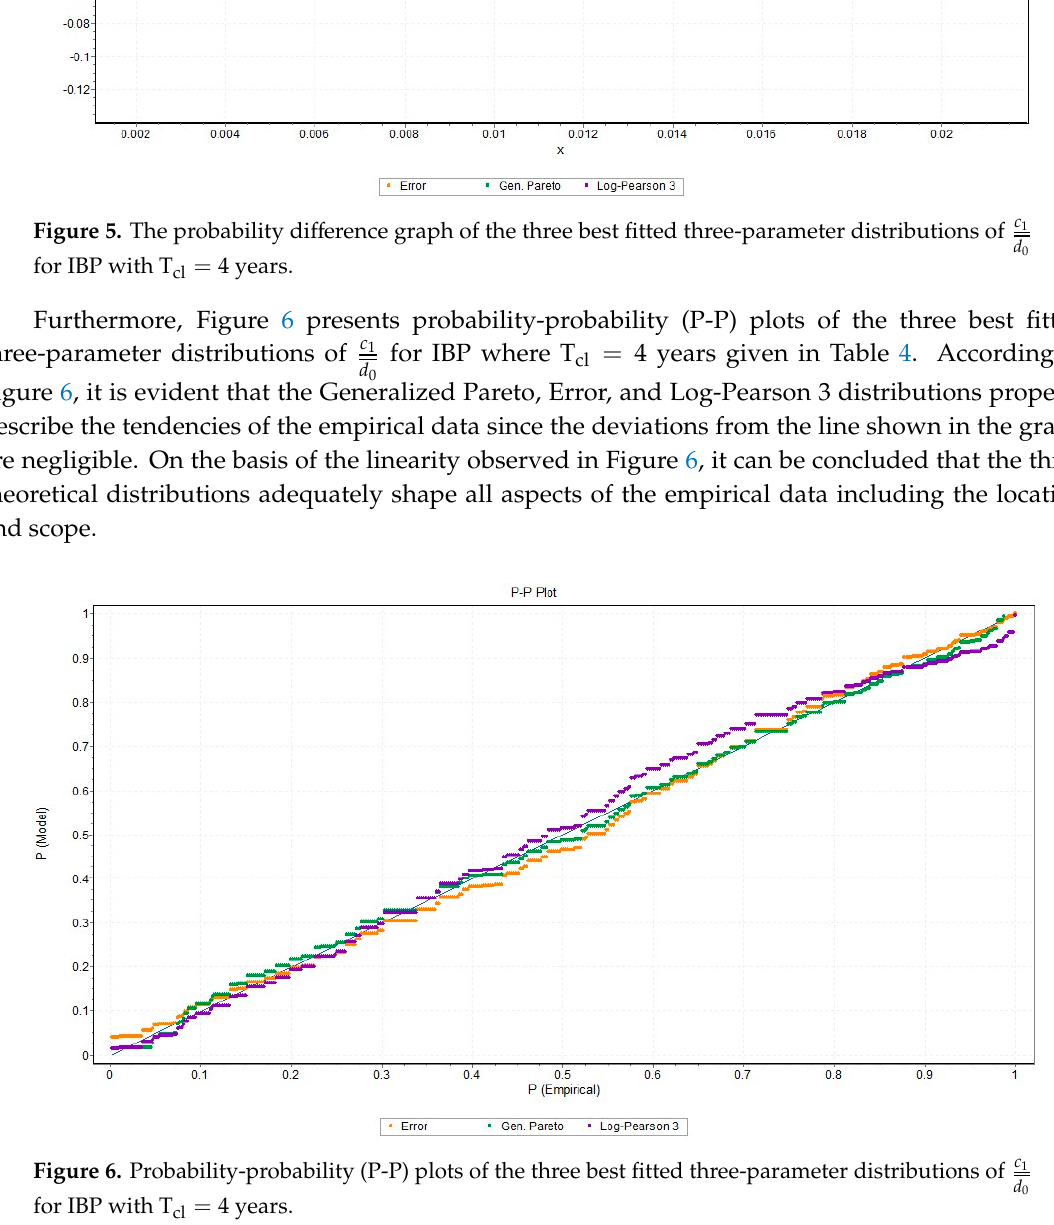
d 0 (cid:3031) (cid:3116)